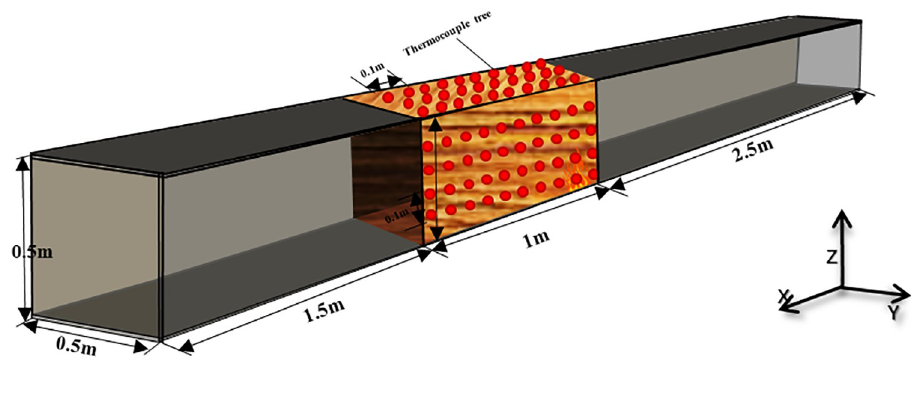
Fig 8. Physical model and the arrangement of thermocouples.